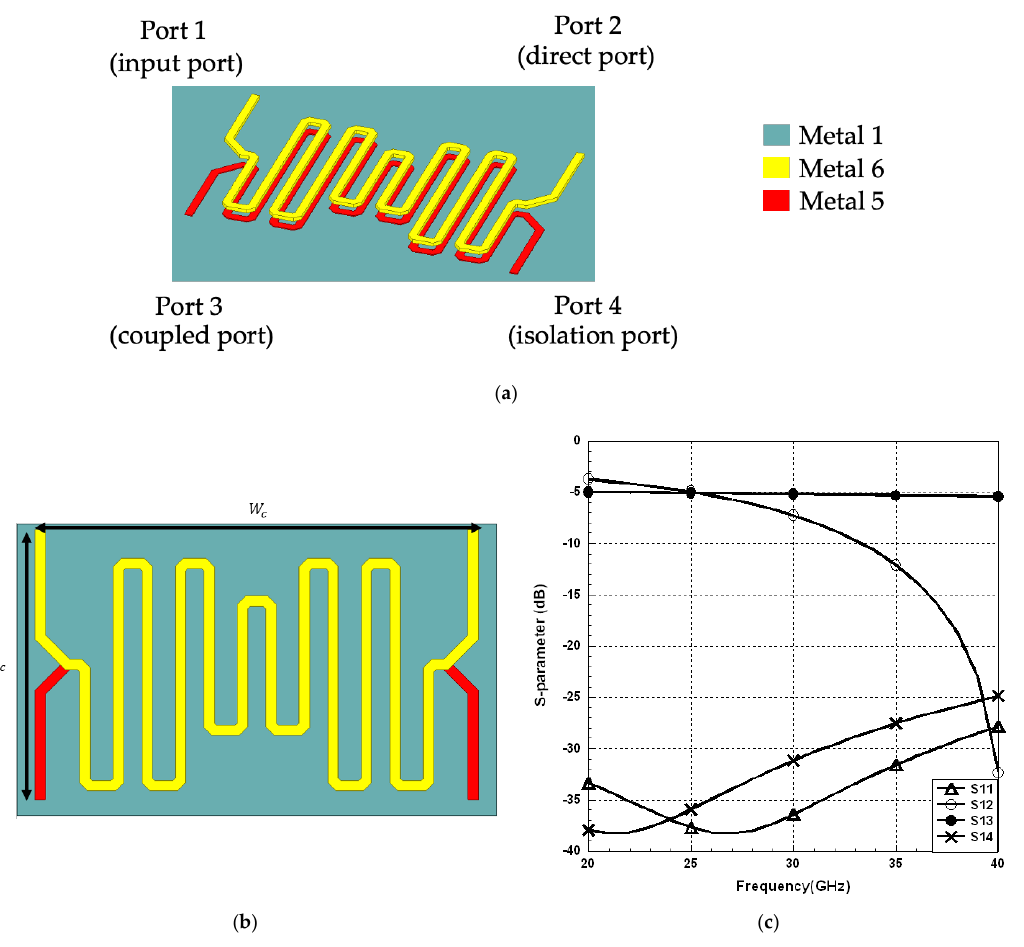
Figure 4. ( a )The layout of the proposed design of the parallel coupler. ( b ) View from the top, 𝐿 𝐶 = 0.216 μm , and 𝑊 𝑐 = 0.129 μm . ( c ) S-parameters include 𝑆 11 ,𝑆 12 ,𝑆 13 , and 𝑆 14 for